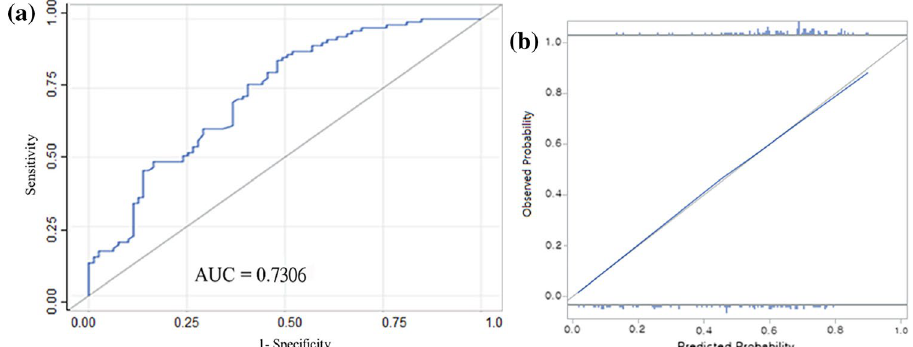
Fig. 2 a Receiver operating characteristic curve of nomo- gram. Validation cohort of 172 patients. b Calibration plot of